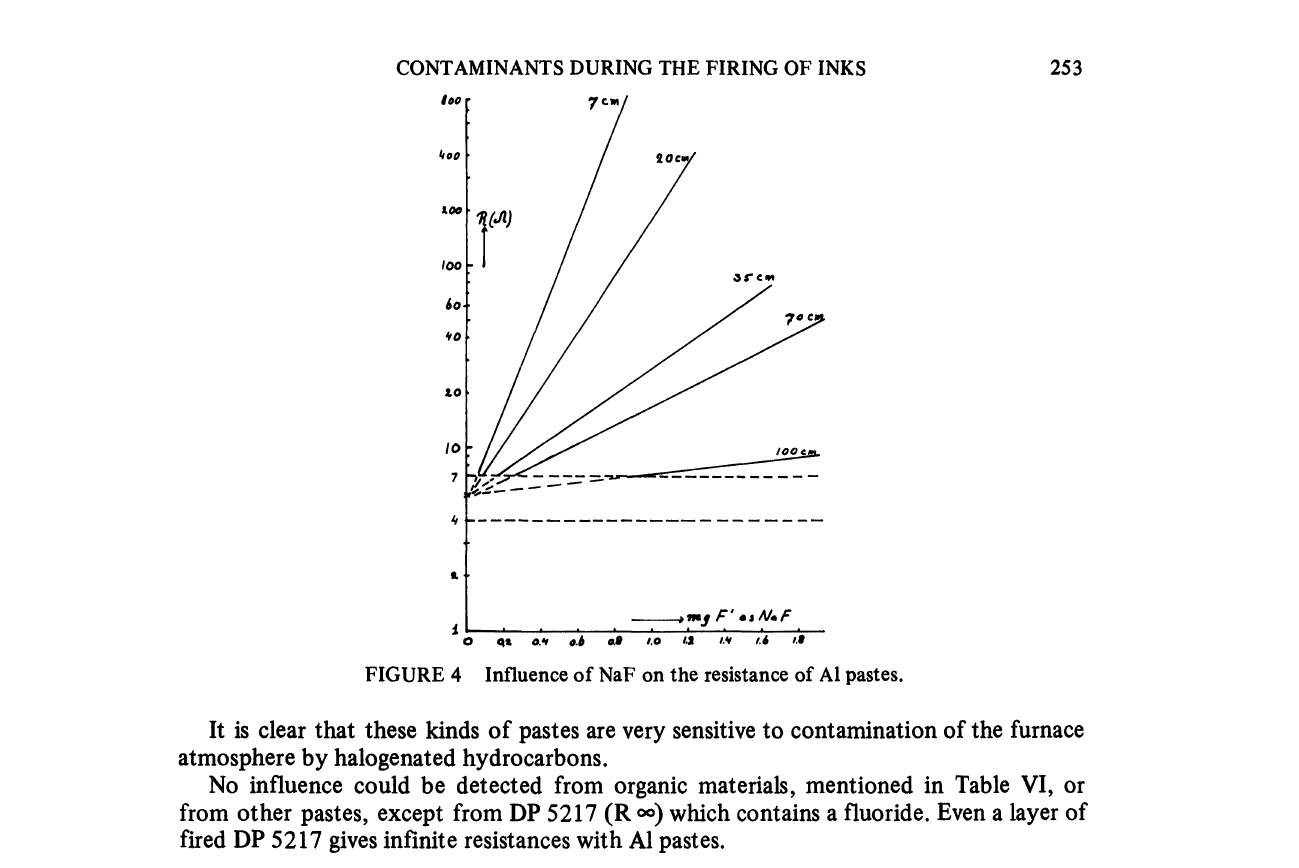
tt 0.6 FIGURE 4 Influence of NaF on the resistance of AI